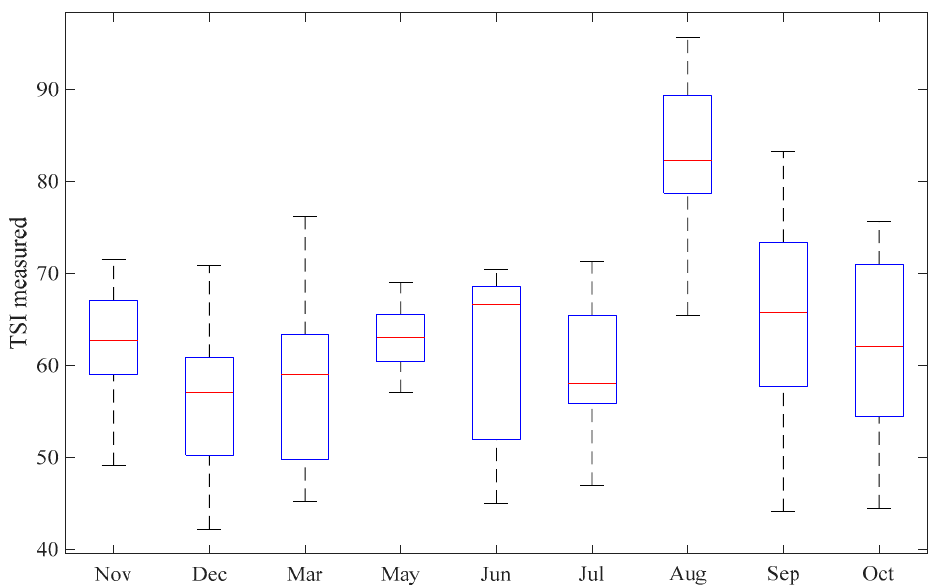
Figure 5. Monthly distribution of TSI calculated using in situ sample data monitoring five trophic indicators between November 2018 and October 2019. Each box marks the TSI between the first and third quartiles. The red line in the box marks the median TSI, and the endpoints mark the 1.5 IQR.